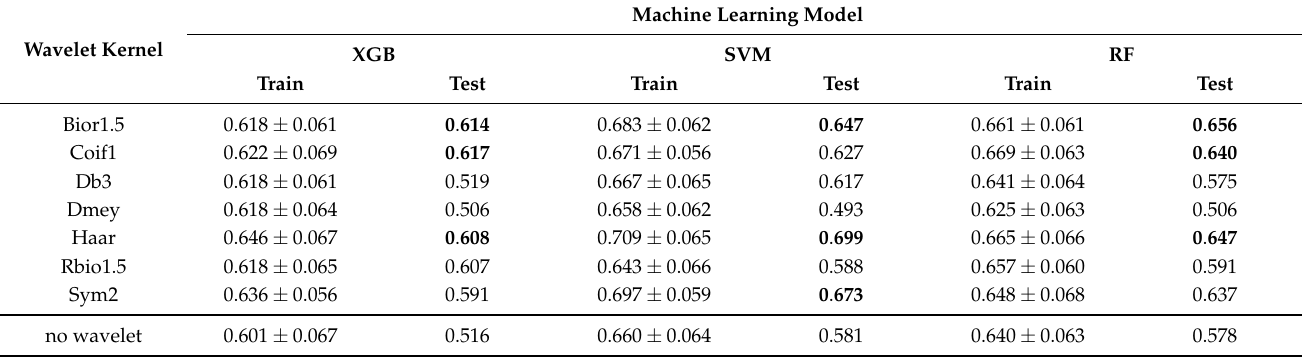
Table 6. Specificity values obtained in training ( mean ± standard deviation ) and in testing phases for each wavelet kernel, with three ML models considered. Boldface values highlight the best three obtained